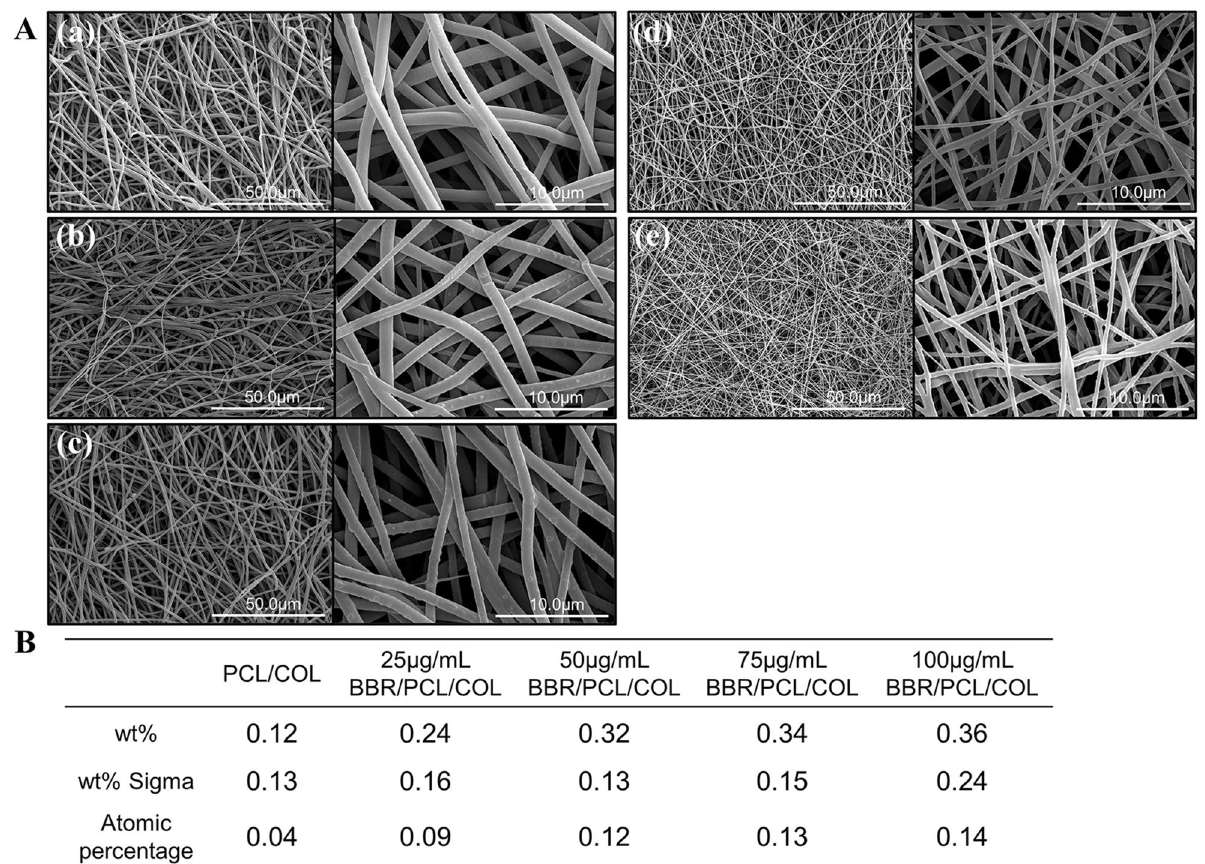
Figure 1. Scaffolds morphology and elemental composition. ( A ) SEM images of PCL/COL scaffold ( a ) and BBR/PCL/COL (25, 50, 75 and 100 μg/mL) scaffolds ( b – e ). ( B ) The Cl elemental compositions of